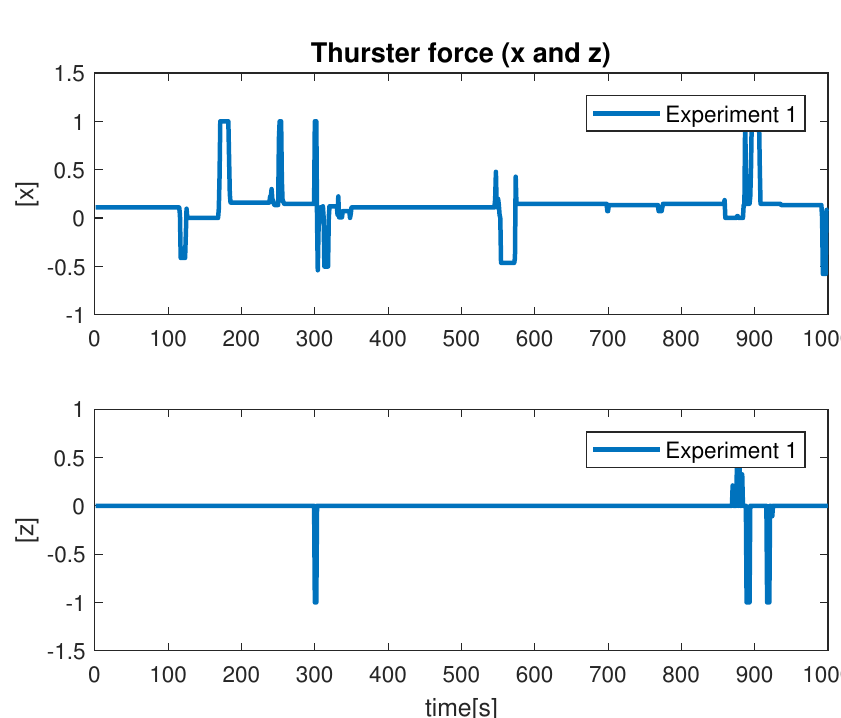
Figure 21. Velocity profile during Experiment